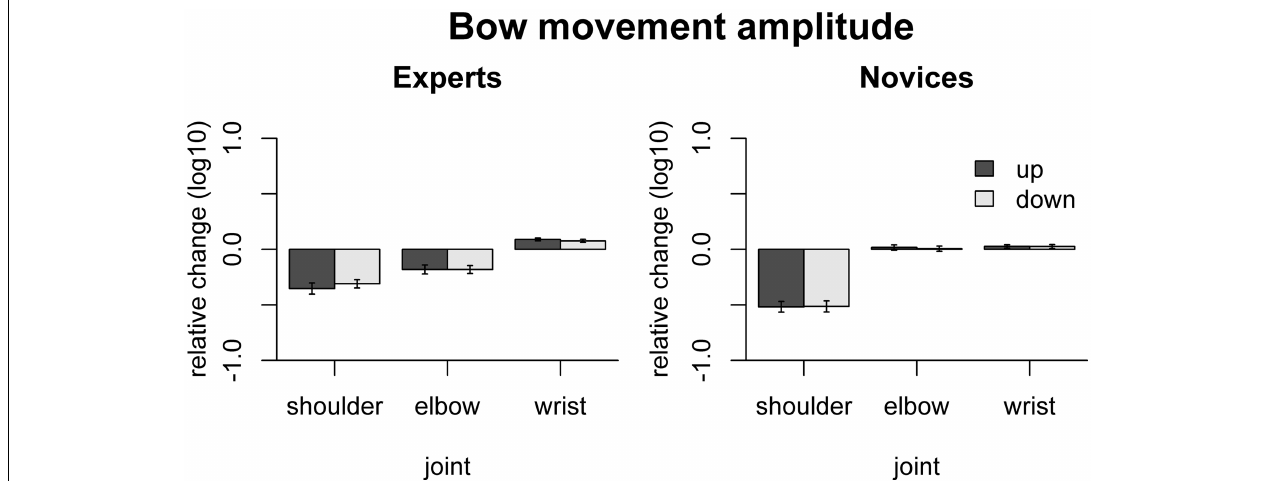
FIGURE 3 | Results of the freezing analysis for bow movement amplitude. The relative change is computed as the log10-transformed ratio between surrogate and original data.Thus, positive values indicate that freezing a particular joint leads to an increase in movement amplitude. Error bars indicate SE across participants.